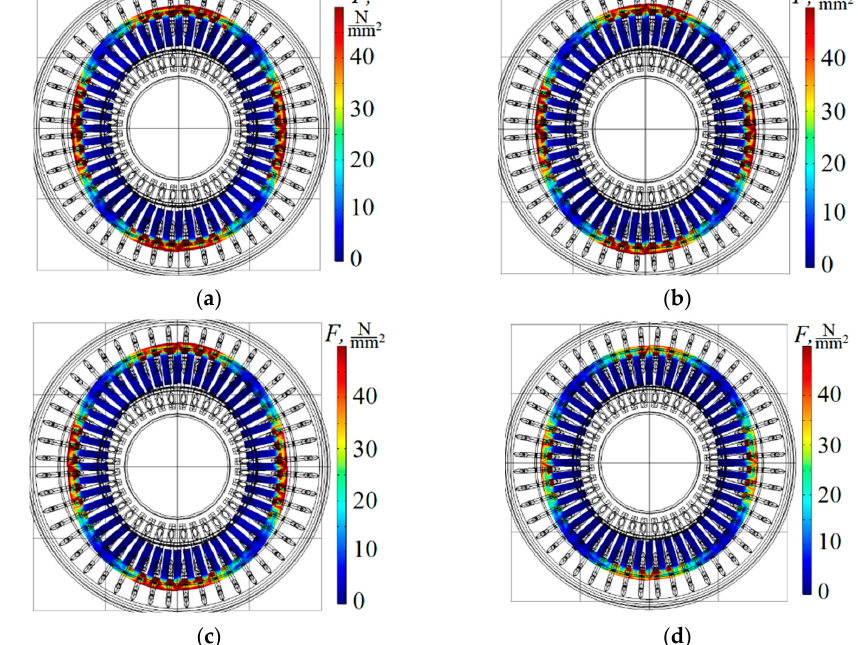
Figure 7. Von Mises stress in the stator core of the investigated motor with supply voltage imbal-